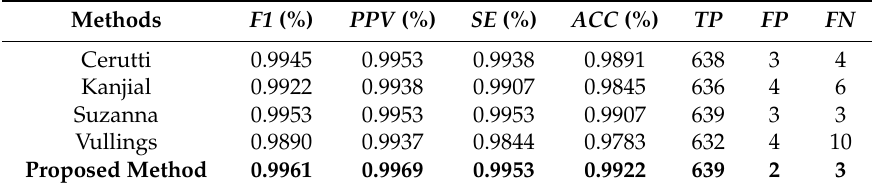
Table 1. FECG QRS detected from statistical assessment of signal r01 (DB1).